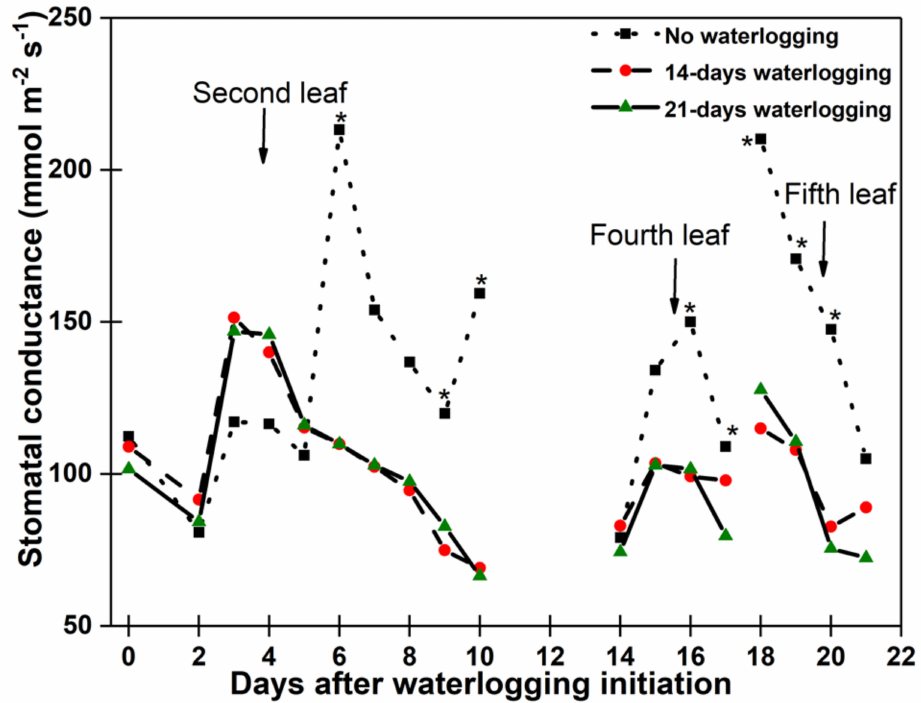
Figure 4. Changes in stomatal conductance of second, fourth, and fifth corn leaves due to waterlogging duration with time. * Significant differences between means among waterlogging duration at p < 0.1. Data was averaged over hybrids to show interaction of different waterlogging duration with time. Days after waterlogging in the x-axis were obtained from the waterlogged